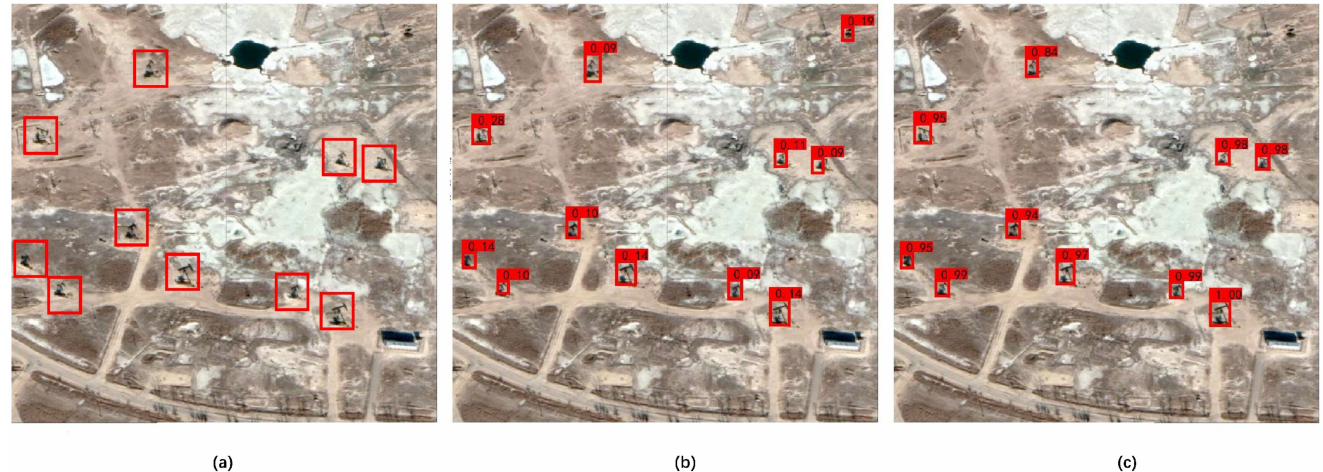
Figure 8. Visual oil well detection results for SSD and YOLO v4. ( a ) the ground truth image; ( b , c ) the detection results obtained by SSD and YOLO